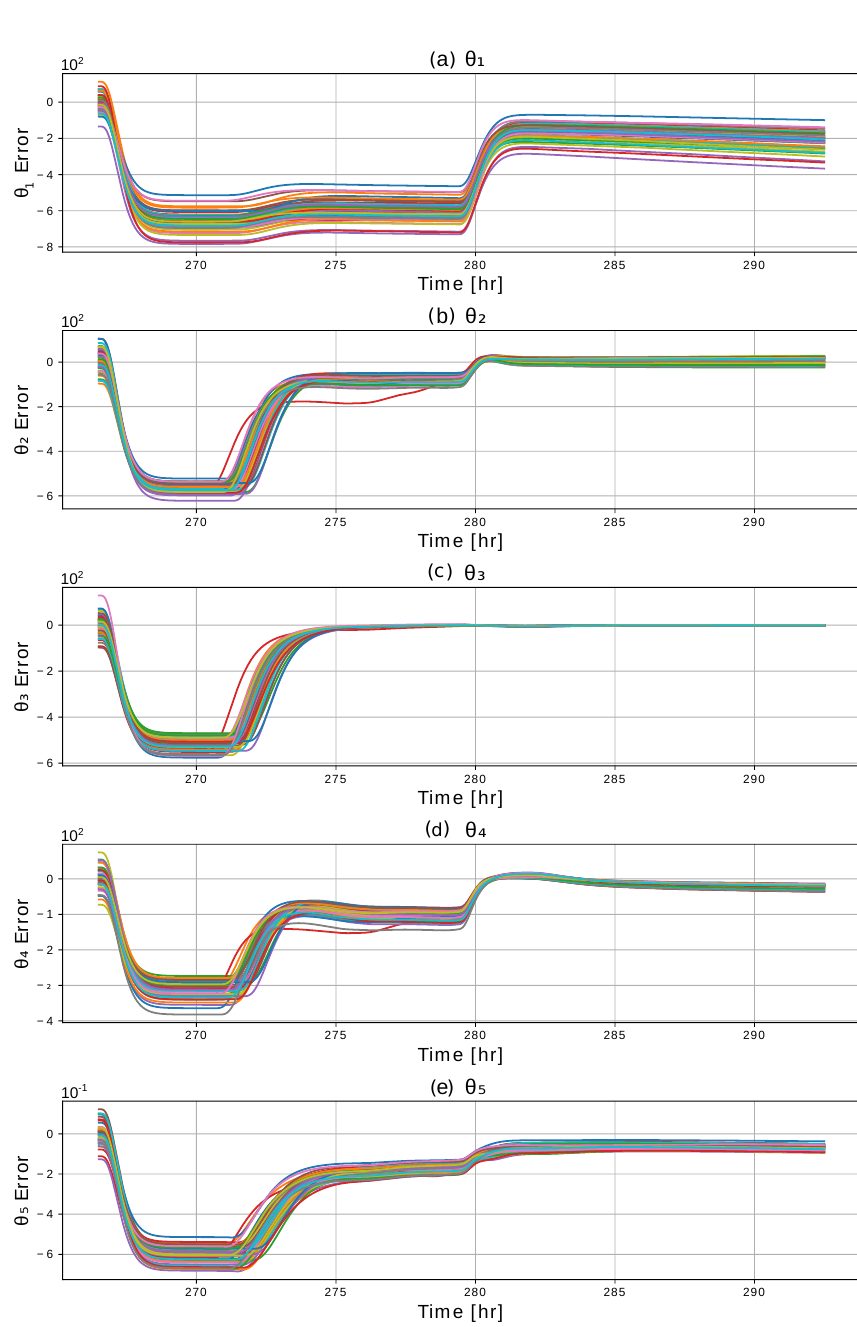
Figure 10. Thermal parameters of the centralized framework updated via Algorithm 1, (N =